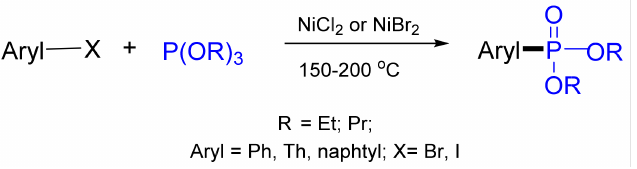
Figure 27. Cross-couplingreactionsofarylhalideswithtriethylphosphitesanddiethylphenylphosphonites.